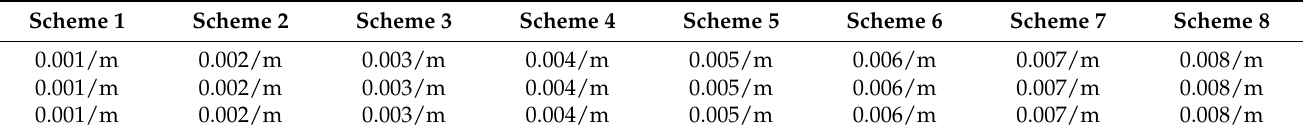
Table 5. Fiber layer thickness design scheme.